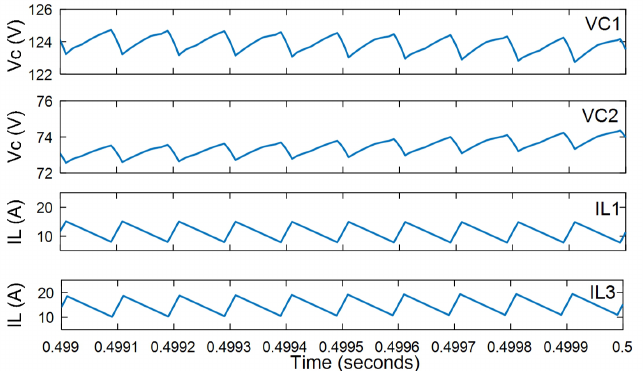
Figure 12. Capacitor and inductor voltage and current ripple.